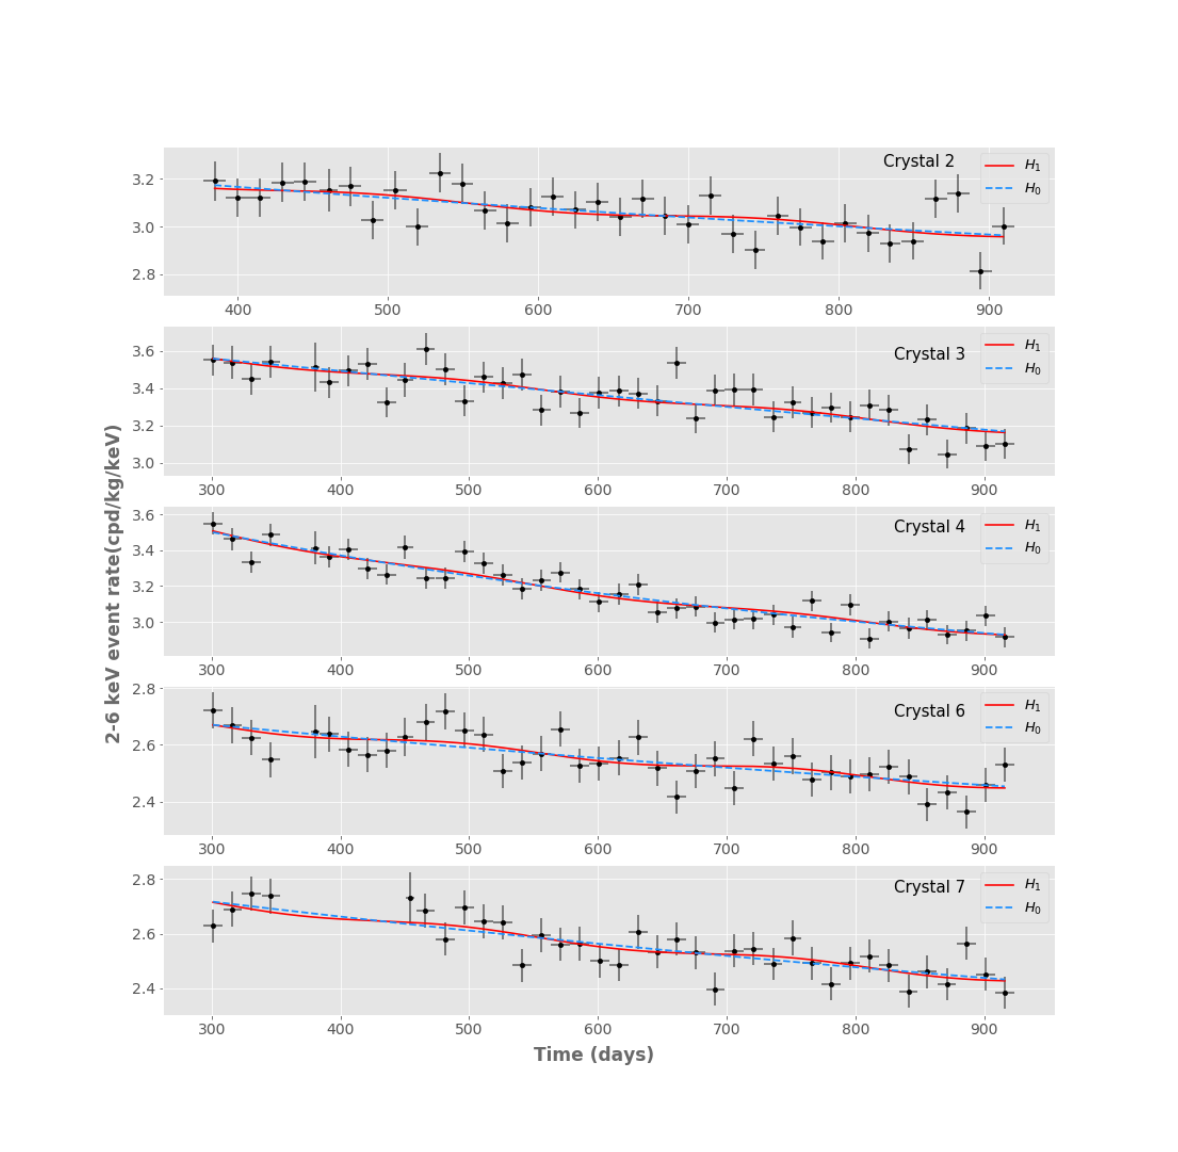
Fig. 1.— The CS100 data points (in black) for all the five crystals are overlaid with the fits calculated for both the hypotheses, sinusoidal modulation with all parameters free H 1 ( t ) (Eq. 1, shown in red), and background-only model H 0 ( t ) (Eq. 2, shown in blue). The best-fit value of ω in this case is equal to 0.024 radians/day or period of about 257